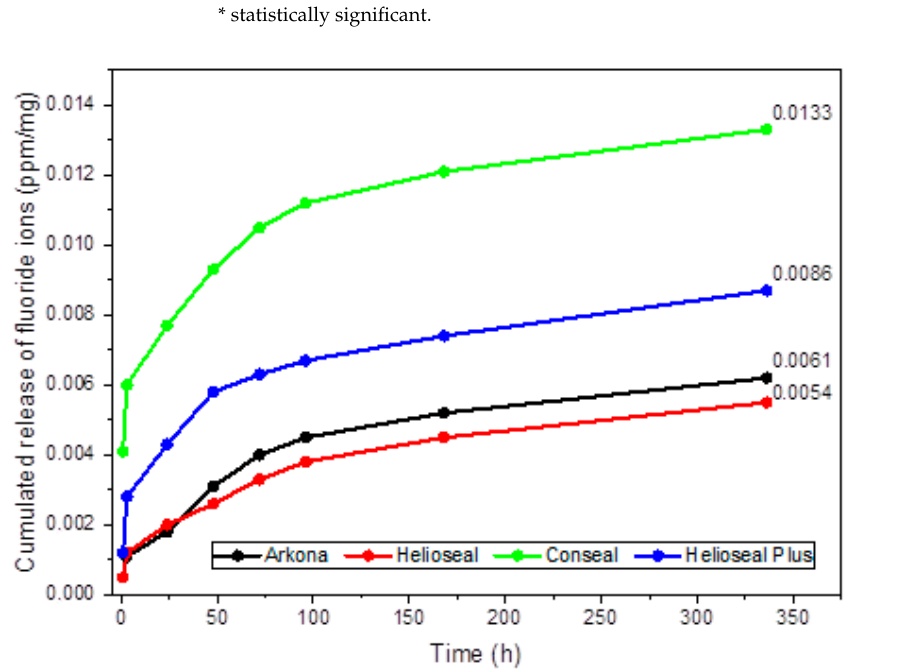
Figure 5. Cumulative fluoride ion release (ppm/mg) from fissure sealants into deionized water. Dots represent the means of measurements.